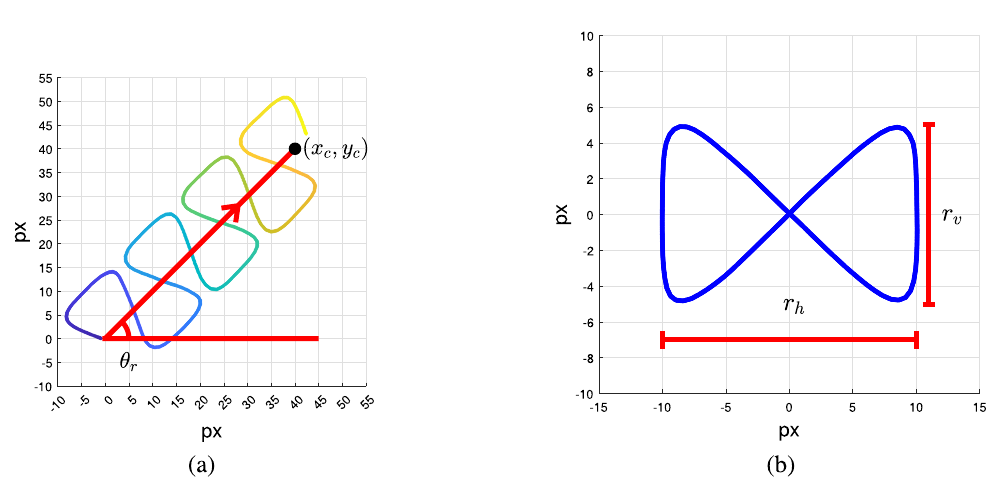
Figure 14. ( a ) Trajectory of simulated linear mean swimming cell (Eqs. 12–15). ( b ) Ribbon-like oscillatory movement along the straight-line path of linear mean swimming cells (Eq.